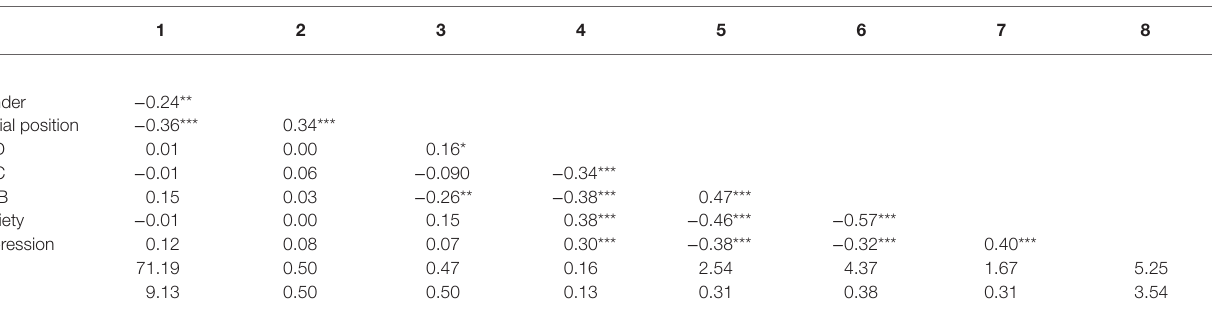
TABLE 1 | Means, SD, and correlations among